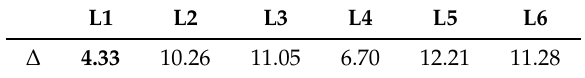
Table 5. Mahalanobis Distances Computed for the Association of Corner L7 of Figure 12.